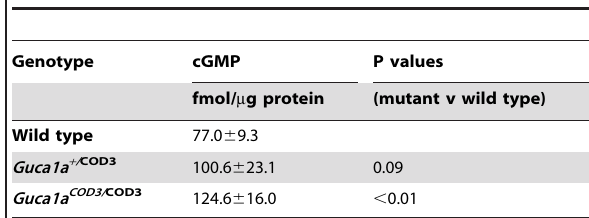
Table 1. cGMP levels in retinae of Guca1a COD3 ‘knock-in’